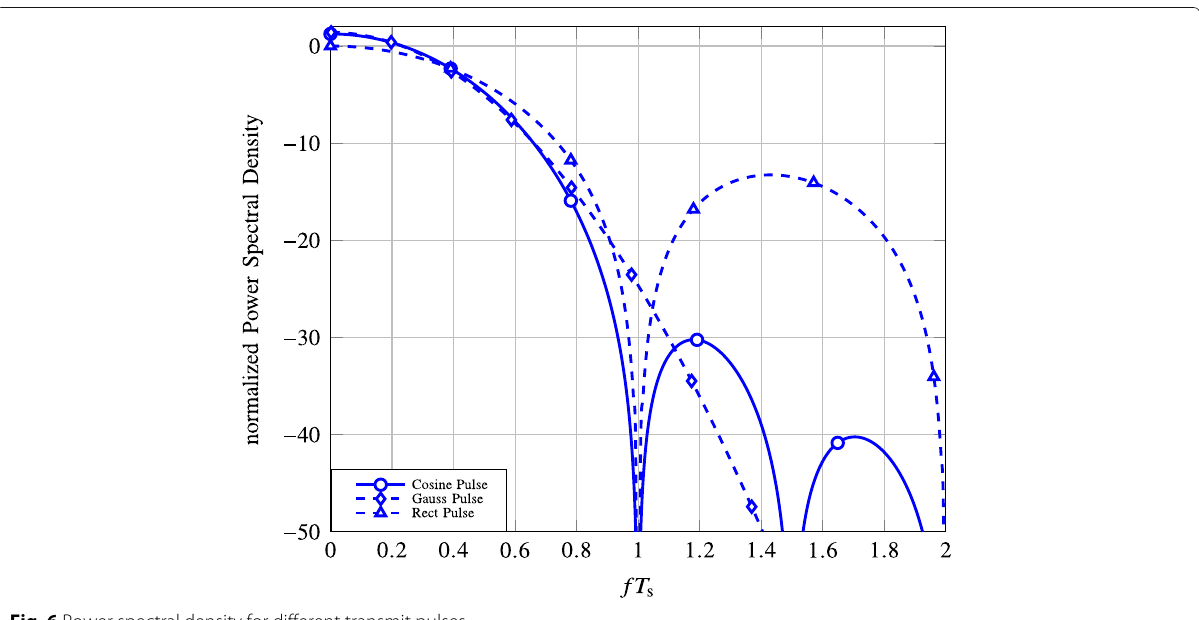
Fig. 6 Power spectral density for different transmit pulses The spectral efficiency as defined in (33) is shown in Fig. 12. It can be observed that the spectral efficiency of i.u.d. input sequences might be higher than with opti- mized input sequences (Section 6) or with reconstructible sequences designed according to the approach presented in Section 4. This effect happens as we do not con- sider any spectral shaping during the sequence design approaches besides the choice of the pulse shape. In this regard, the bandwidth depends on the sequence design